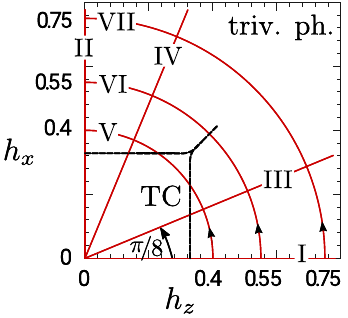
FIG. 3. Qualitative phase diagram of the toric code with x and z magnetic field [Eq. (42)]. Phase boundaries are indicated in black, and lines which we study in detail later on in red, labeled by roman numbers I – VII. There is a toric code phase (TC) at a small field, which for large field transitions into a trivial phase > h either through flux condensation ( h ) or charge condensa- z x > h ). The model exhibits a duality under exchanging tion ( h x z ↔ h h and simultaneously electric and magnetic excitations. x z h Along the self-dual line h , there is a first-order line x ¼ z separating the two different anyon condensation mechanisms through which the trivial phase can be obtained, which ends at a sufficiently large field and is replaced by a crossover